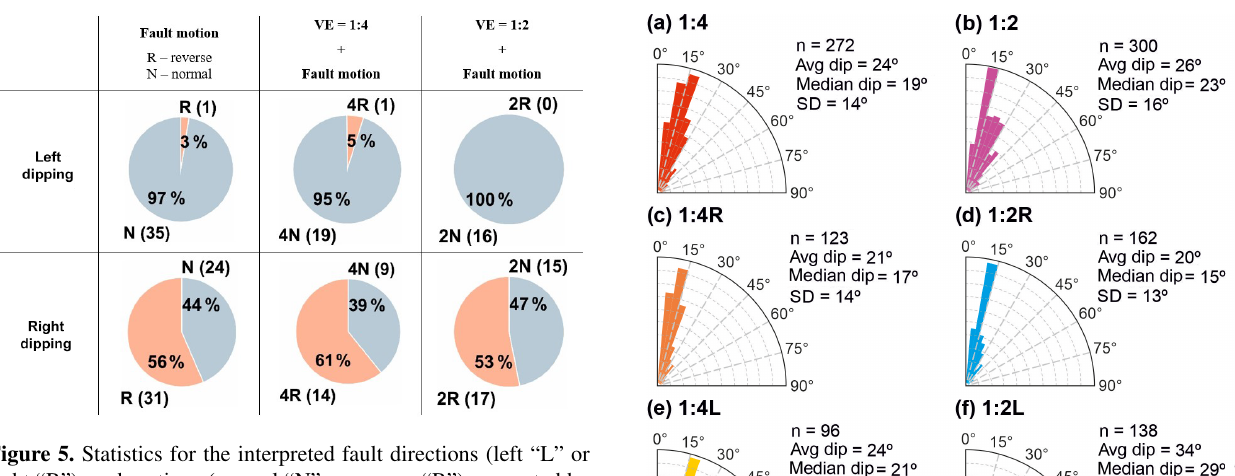
with right-dipping horizons (Fig. 3b), (2) rightward-dipping thrust faults with right-dipping horizons (Fig. 3c), and (3) rightward-dipping normal faults with left-dipping hori- zons (Fig. 3d). Only one interpretation showed leftward- dipping faults with left-dipping horizons and marked the mo- tion of the faults as reverse (Fig. 5). In addition, this inter- pretation did not show any evidence of correlating horizons across the fault and simply used arrows to mark the